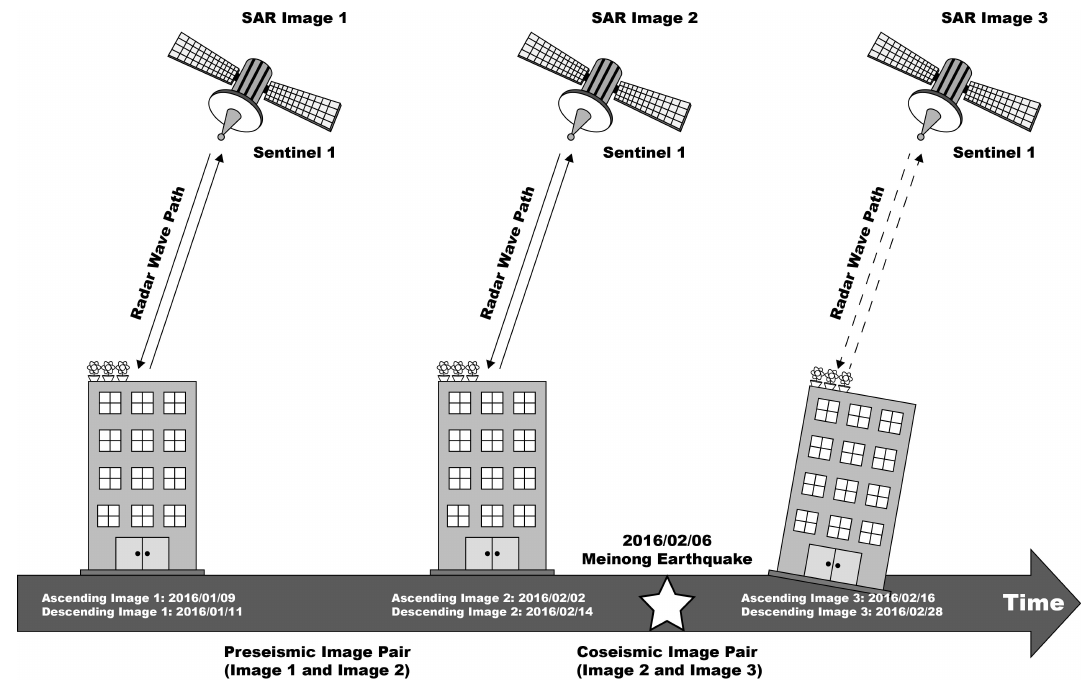
Figure 3. Conceptual diagram that shows the decrease of coherence before and after an earthquake. SAR: synthetic aperture